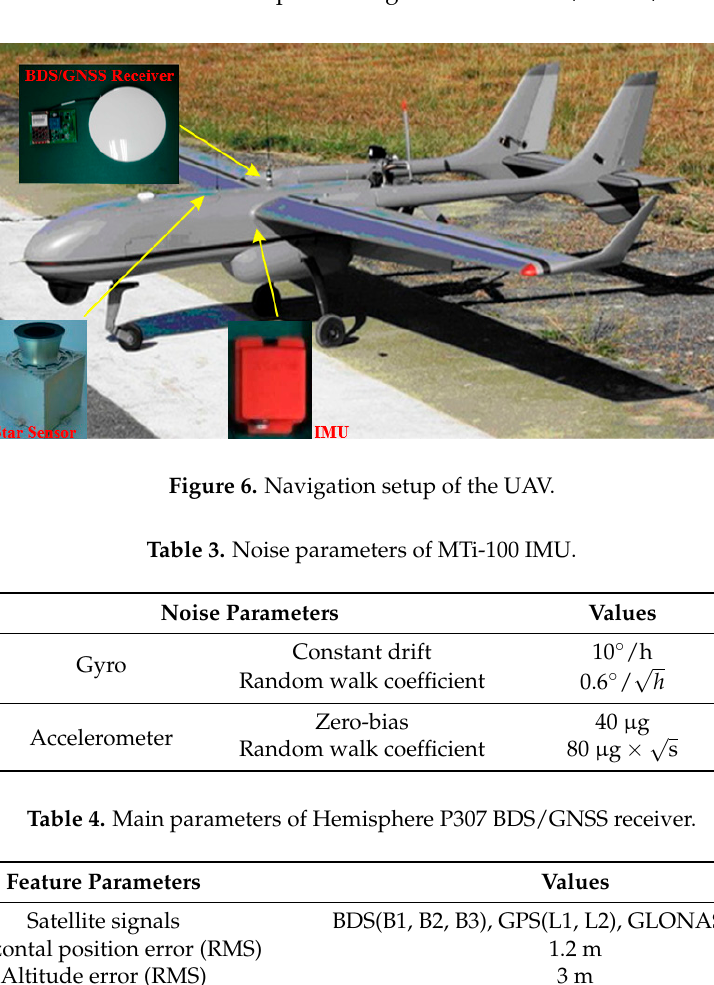
Table 5. Main parameters of SODERN SED26 star sensor.